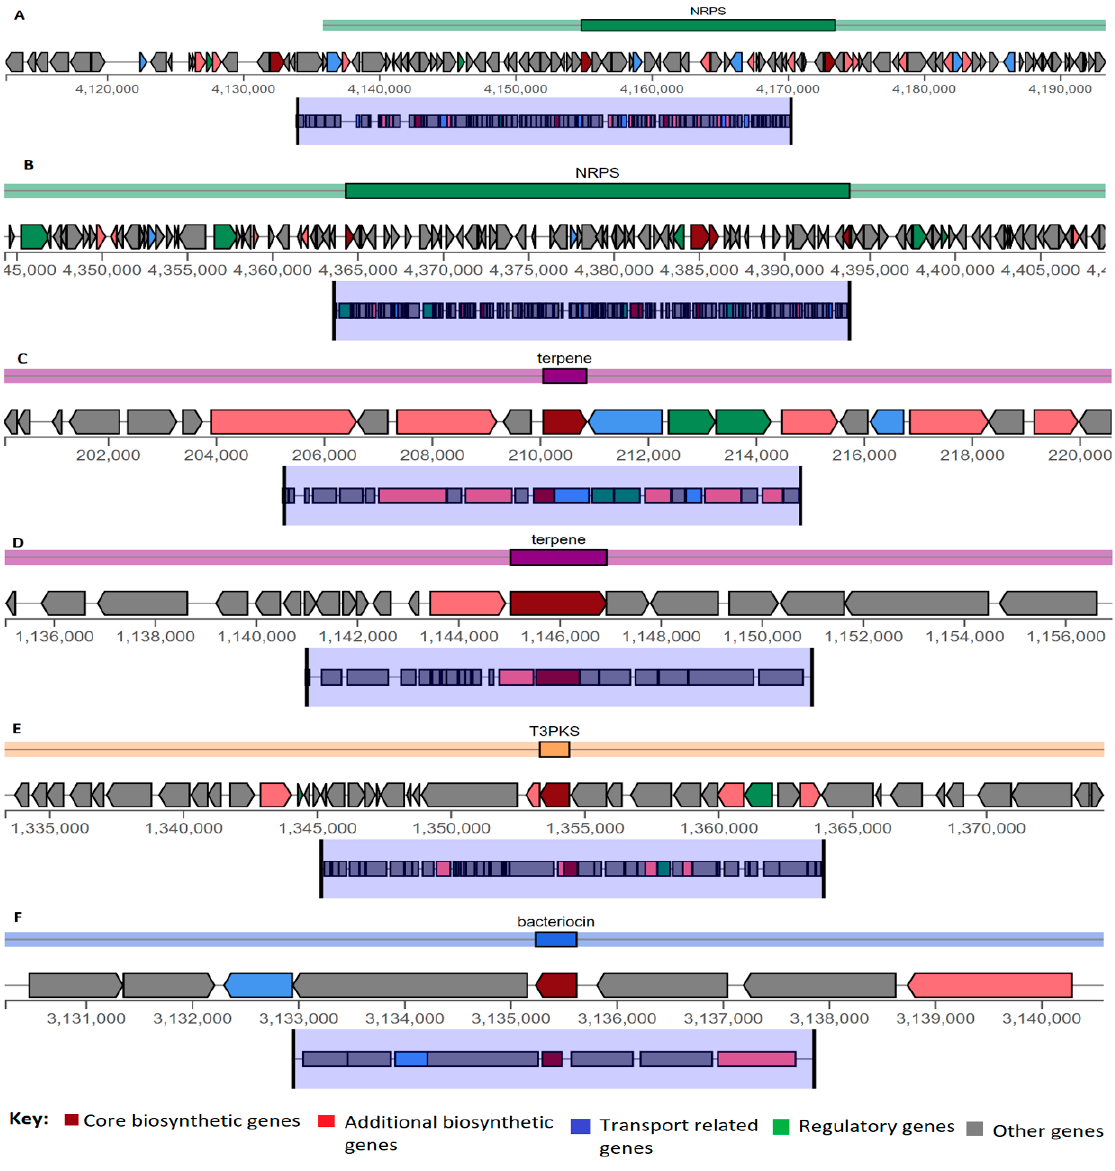
Figure 4. Organization of putative novel BGCs coding for: ( A ) bogorol A (NRPS); ( B ) surfactin (NRPS); ( C ) terpene; ( D ) terpene; ( E ) type 3 polyketide (T3PK); ( F ) RiPP (Bacteriocin), in B. subtilis RS10 genome.